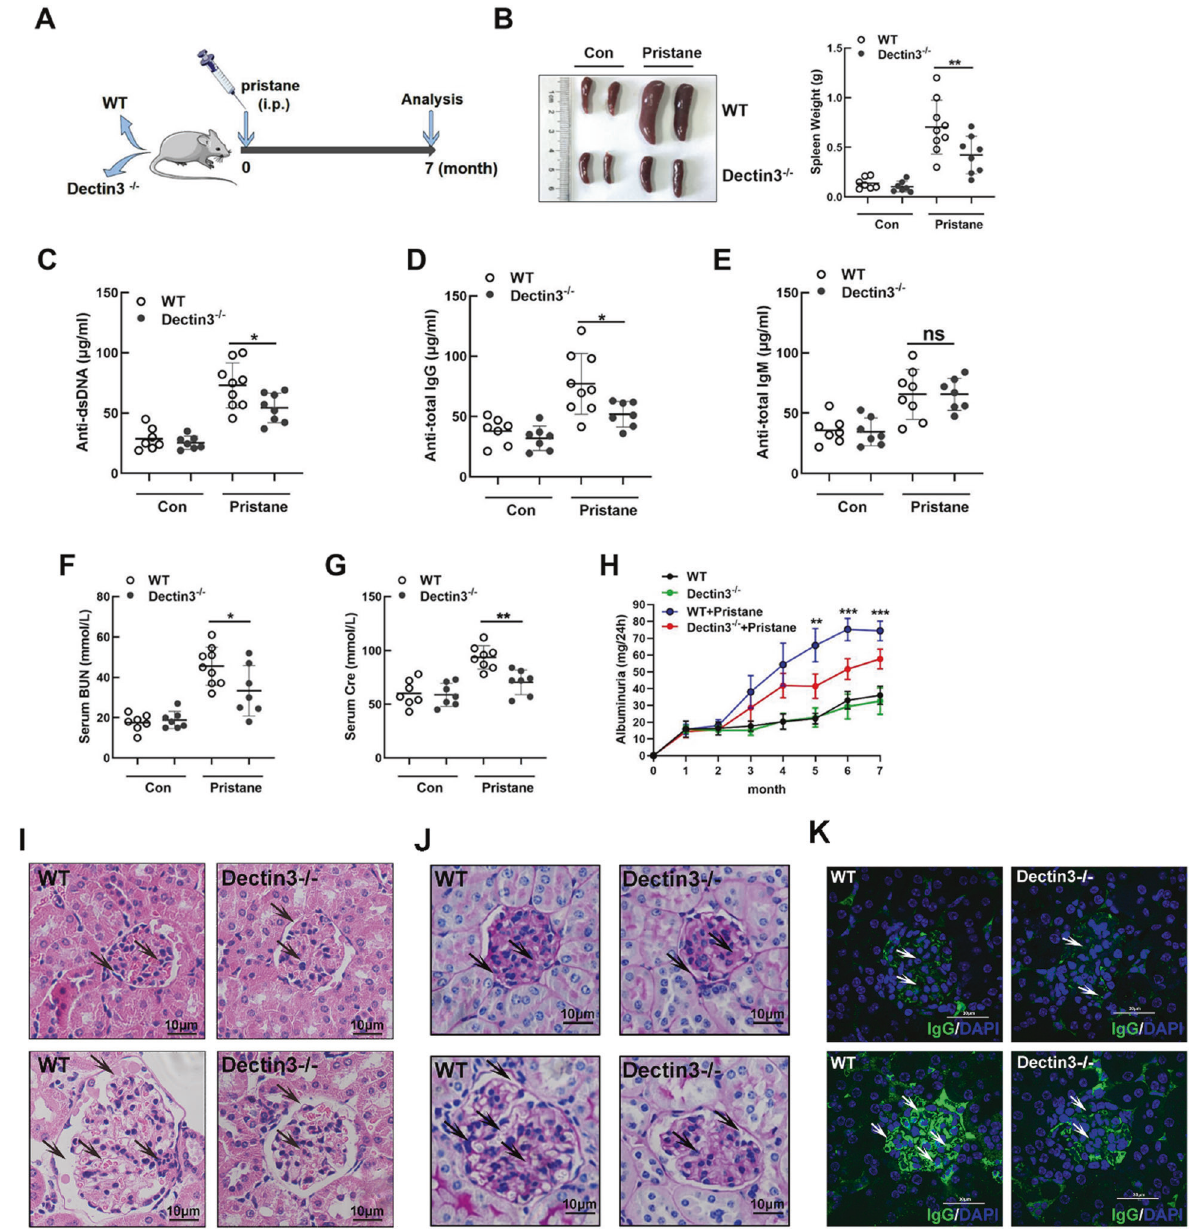
Fig. 1 Dectin3 de fi ciency prevented pristane-induced lupus-like disease. A Schematic diagram of a pristine-induced lupus mouse model. B Representative photographs of spleens and spleen weights. C Serum level of anti-dsDNA was measured using ELISA. D , E ELISA of the serum levels of total IgG and IgM. F , G ELISA of the serum levels of BUN and Cre. H The level of mouse urine protein was detected using ELISA. I , J HE and PAS staining of kidney sections (scale bar = 10 μ M). K IgG deposits in glomeruli were detected by immuno fl uorescence analysis (scale bar = 30 μ M). Data represent the mean scores ± SEM. * P ≤ 0.05, * P ≤ 0.01, *** P ≤ 0.001; n = 7 – 9 mice in each